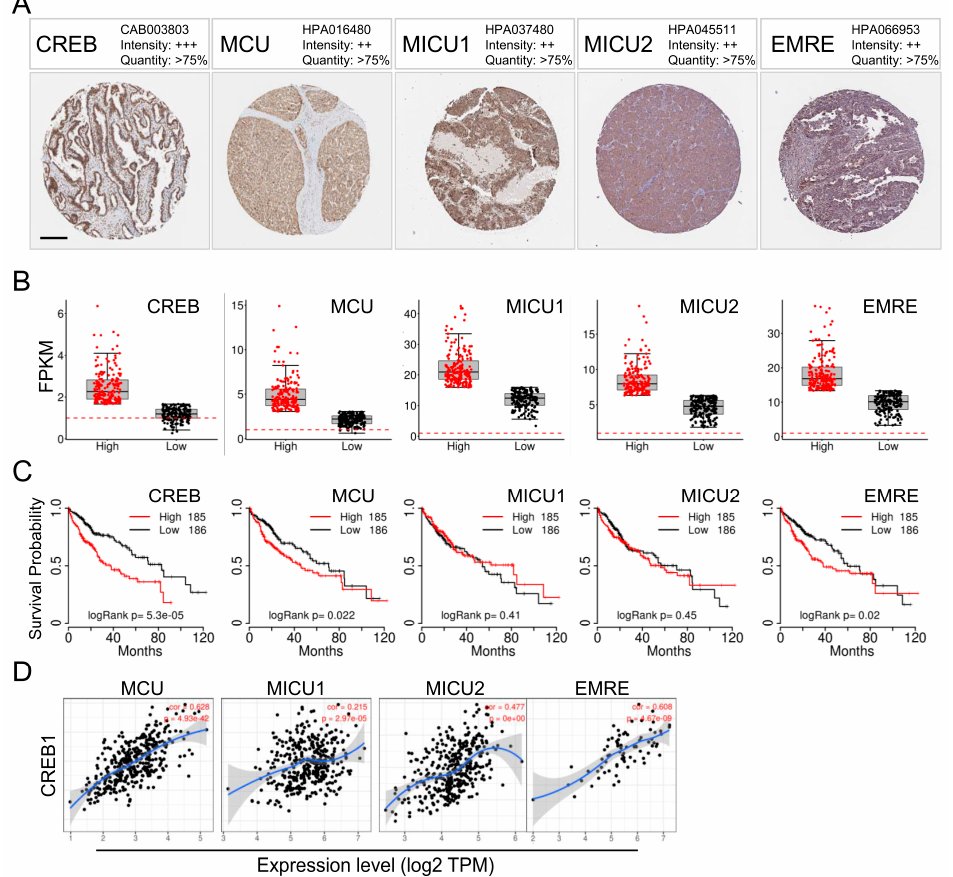
Figure 1. CREB, MCU, MICU1, and MICU2 expression in HCC and its effect on prognosis. ( A ) Representative images of CREB, MCU, MICU1, and MICU2 immunohistochemistry (IHC) staining in HCC from the Human Protein Atlas (HPA) ( B ) Plots chart showing higher CREB, MCU, MICU1, and MICU2 expression in HCC patients. Data were obtained from TCGA. ( C ) Kaplan–Meier curves of overall survival in HCC patients. Survival data were obtained from TCGA. CREB expression was positively correlated with the expression of MCU, MICU1, and MICU2 in TCGA dataset ( D ). Scale bars 200 μ m.